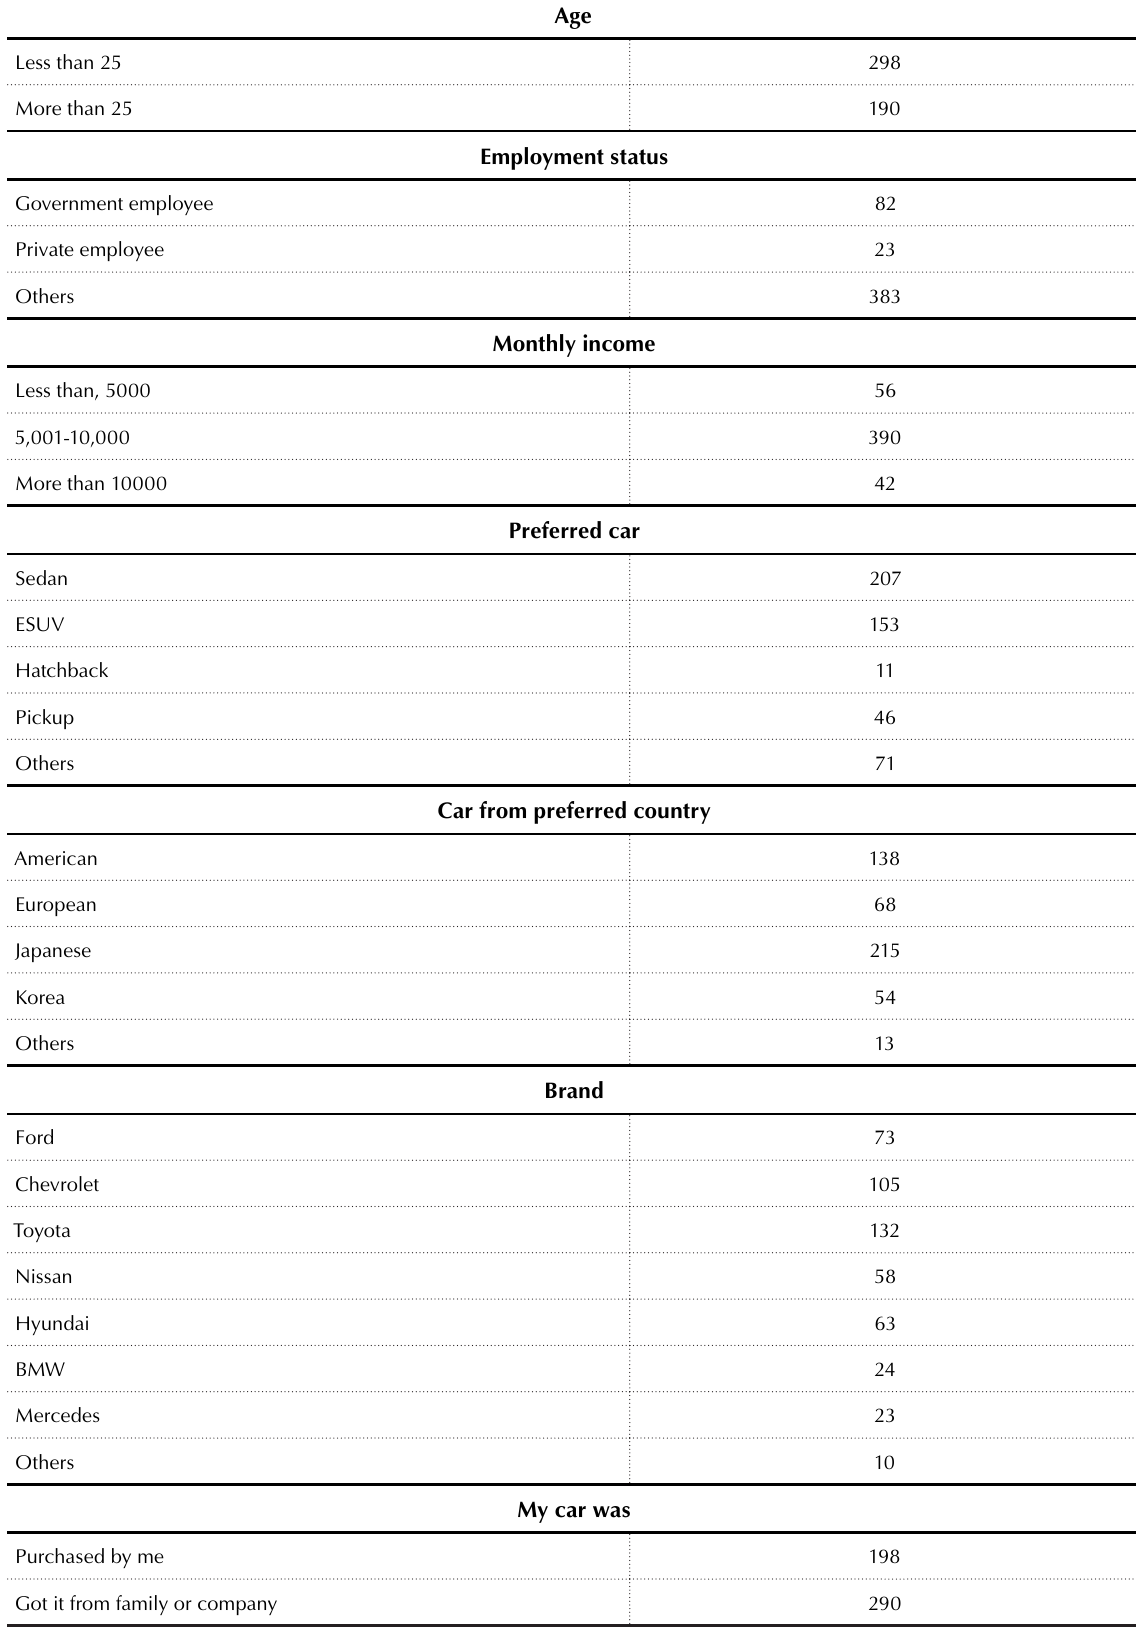
Table 1. Demographic features of the